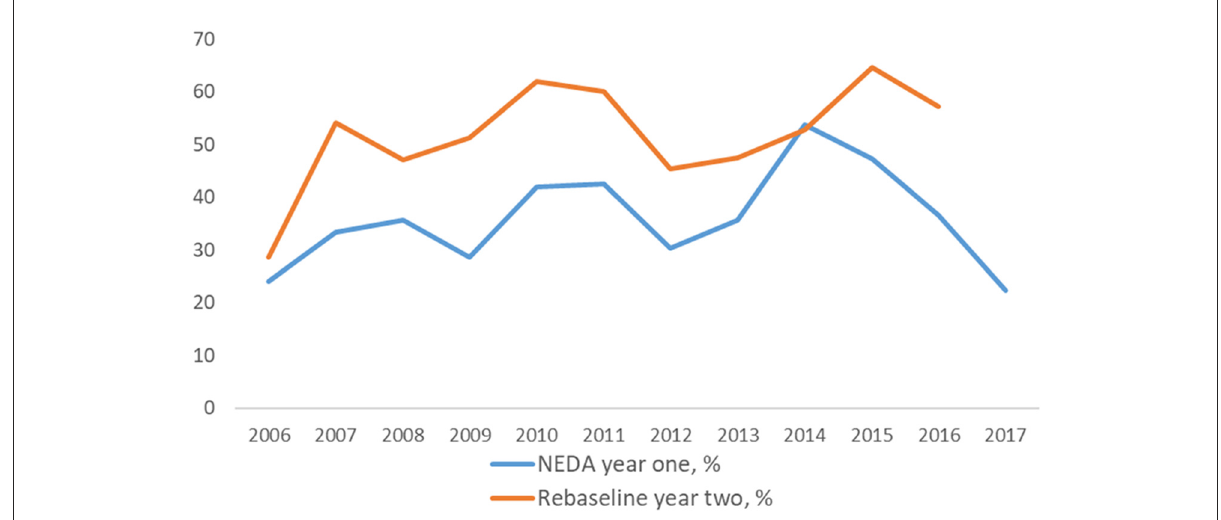
FIGURE2 Proportion of pwMS who achieved NEDA at year one and at rebaseline by year of diagnosis. NEDA, no evidence of disease activity.